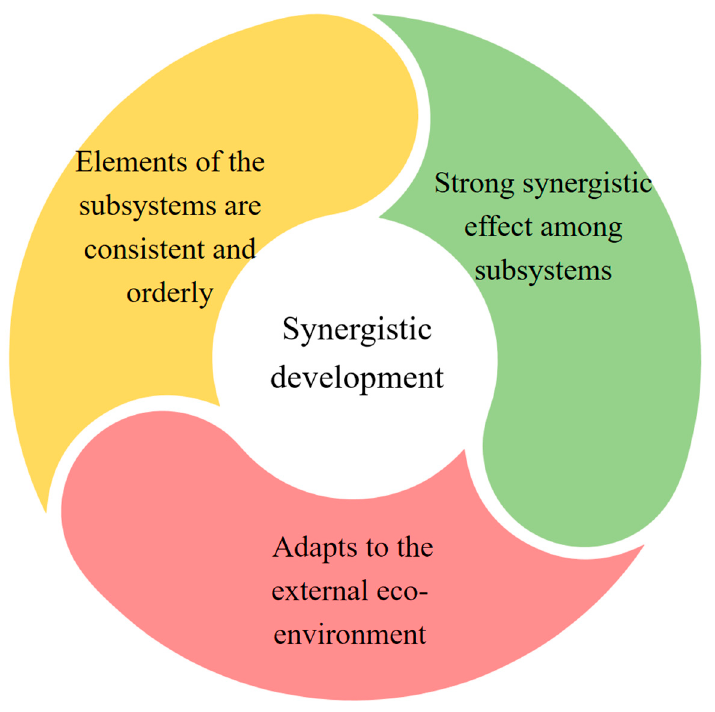
Figure 3. The e ff ects of synergistic development. Figure 3. The effects of synergistic